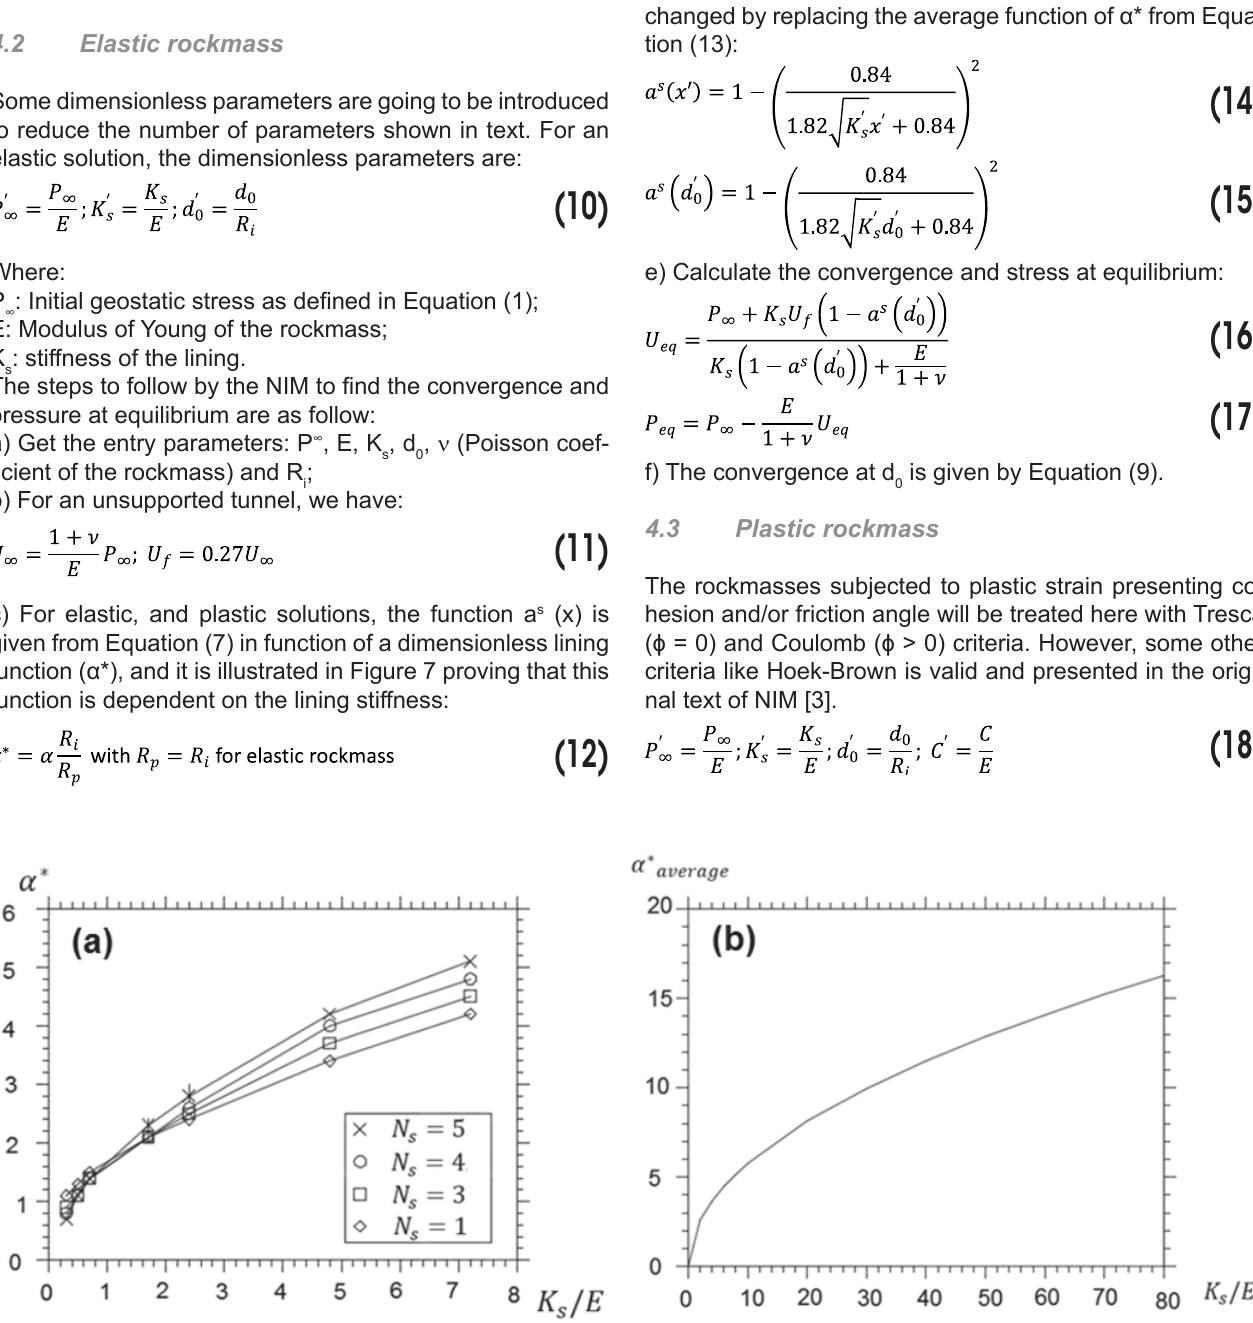
and (b) dimensionless average lining function α * for N s